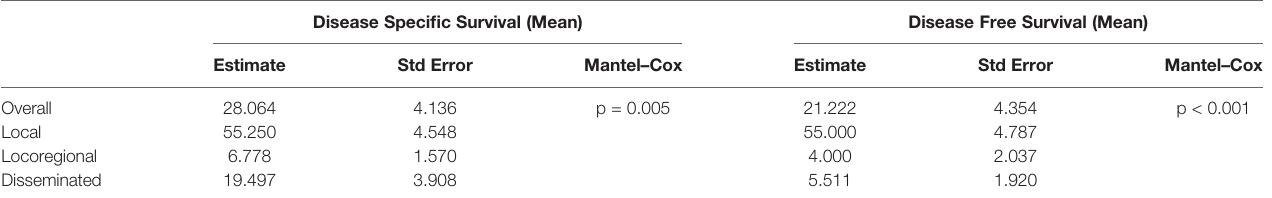
TABLE 4 | Disease-speci fi c and disease-free survival calculations from Kaplan – Meier survival analysis. Disease Speci fi c Survival